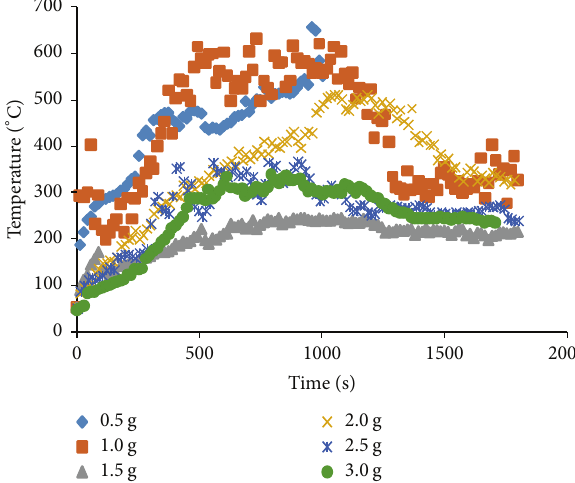
Figure 12: Changes in the temperature of a coated composite with fire-retardant material and an uncoated one during the burning process.